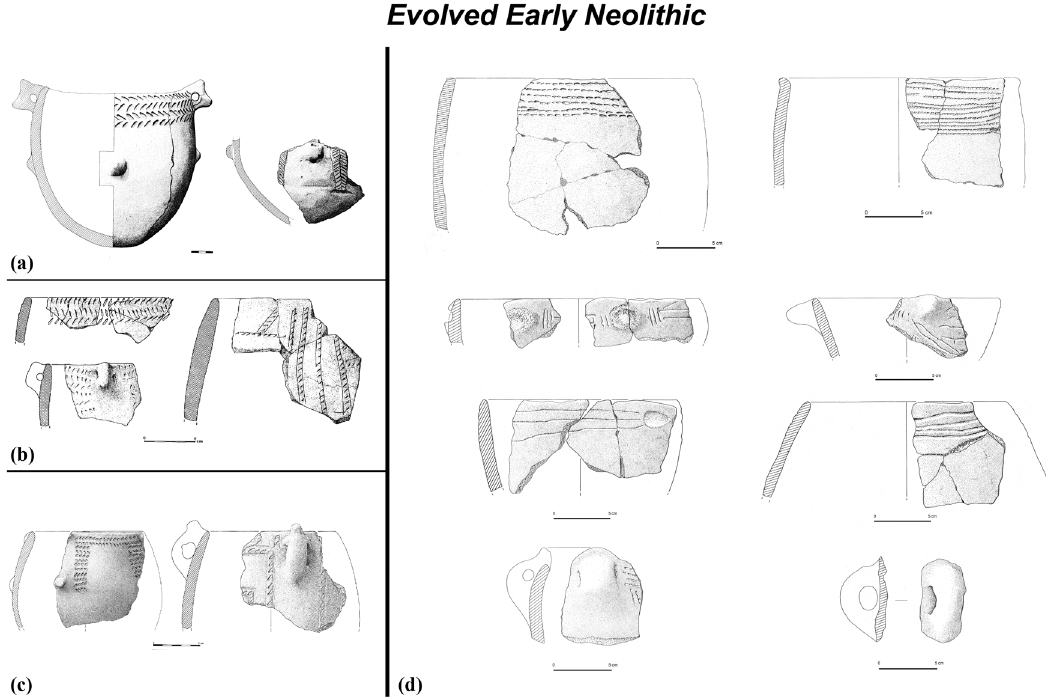
Figure 2: Evolved Early Neolithic ( ∼ 5200 – 4500 cal BC ) : pottery decoration. ( a ) Senhora da Luz ( Estremadura region ) ; ( b ) Abrigo Grande das Bocas ( Estremadura region ) ; ( c ) São Pedro de Canaferrim ( Estremadura region ) ; ( d ) Valada do Mato ( Inland Alentejo ) . Adapted from: Cardoso et al., ( 1996 ) , Carreira ( 1994 ) , Simões ( 1999 ) , and Diniz ( 2007 )